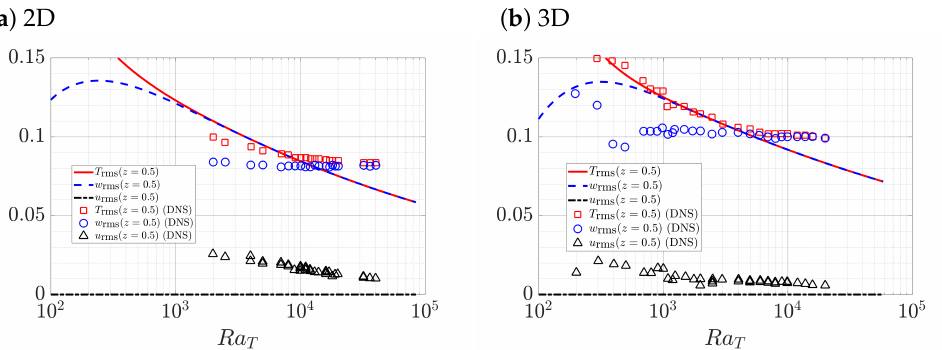
Figure 3. Comparisons of the RMS values at z = 0.5 obtained from single-mode solutions (lines) with DNS (markers). Panel ( a ) shows 2D results with DNS data obtained from Figure 3b in [25], while panel ( b ) displays 3D results with DNS data obtained from Figure 8a in